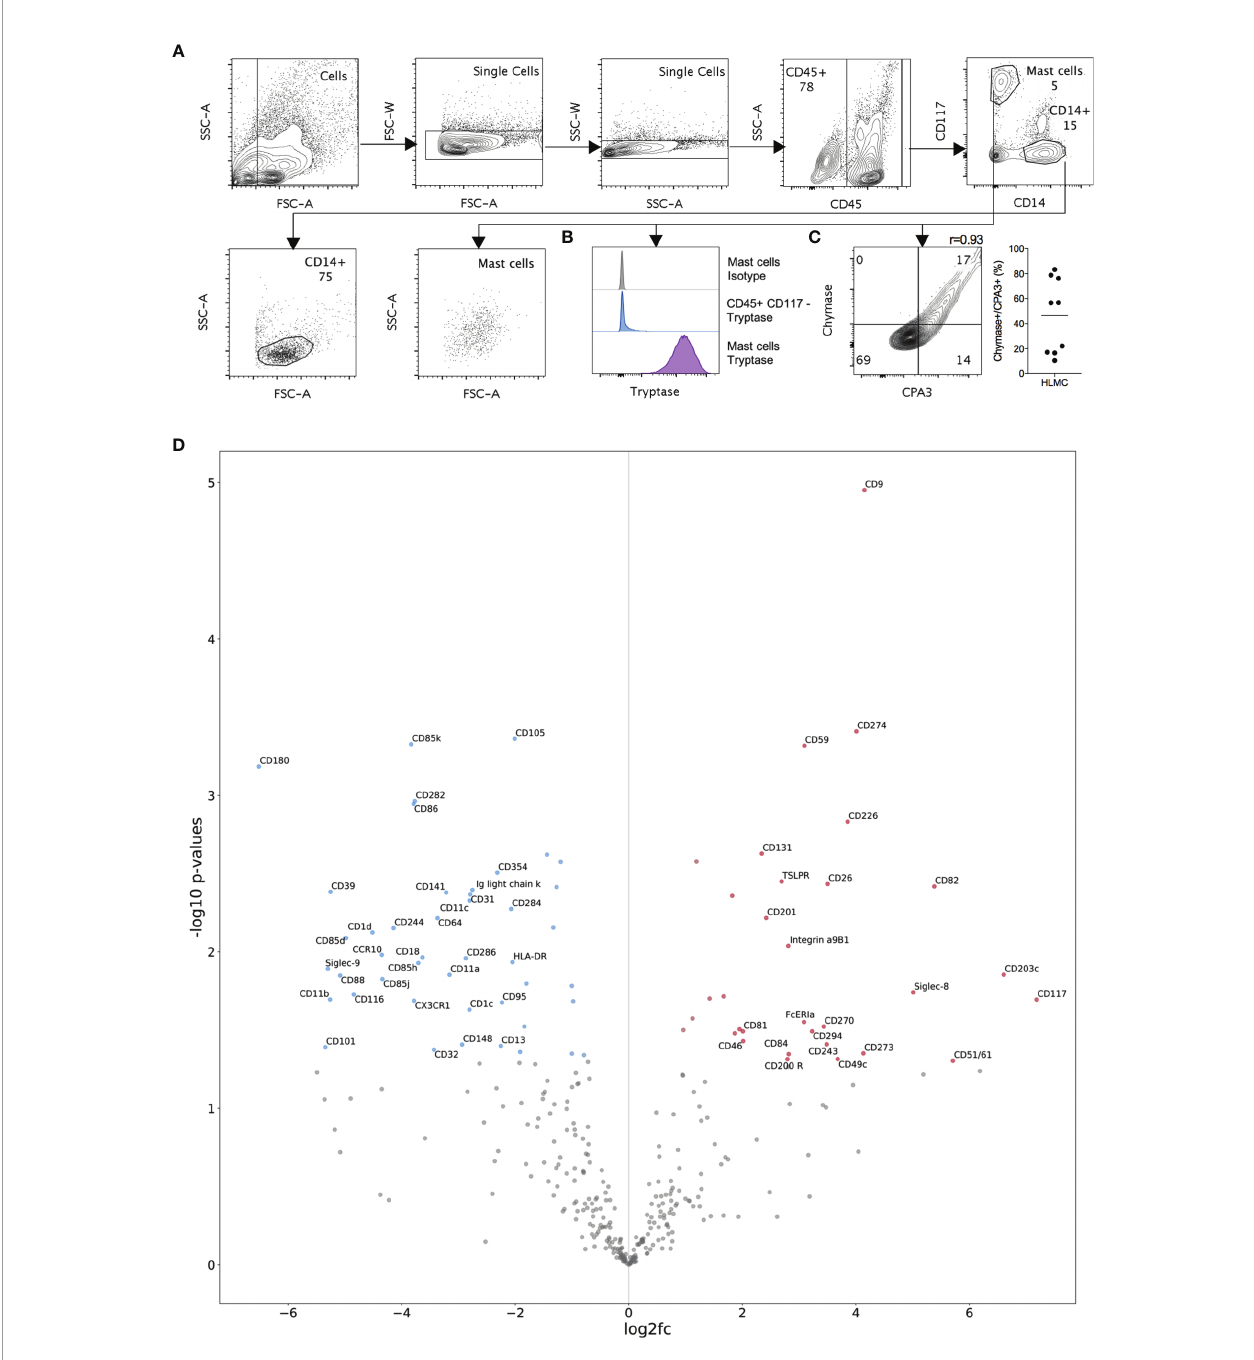
FIGURE 1 | Protease expression and LEGENDScreen analysis of HLMC. (A) Representative gating strategies for HLMCs and CD14 + cells are shown. (B) Intracellular tryptase-, (C) chymase- and CPA3- stained HLMCs and quanti fi cation of CPA3 + /Chymase + cells n = 9. (D) Comparison of marker expression included in the LEGENDScreen kit between mast cells and CD14 + cells. Volcano plot showing log2-fold change in mast cells divided by CD14 + cells (normalized MFI values with the plate-matched FMO subtracted) against -log10 p-values (independent 2-sided t-test) of mast cells against CD14 + cells. Markers are annotated only if abs(log2fc) => 2 and p-value < 0.05. n =